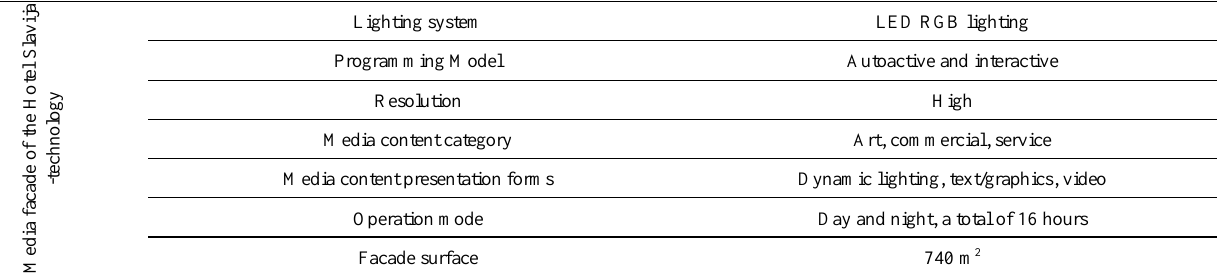
Table 8. Parameters of media facade technologies